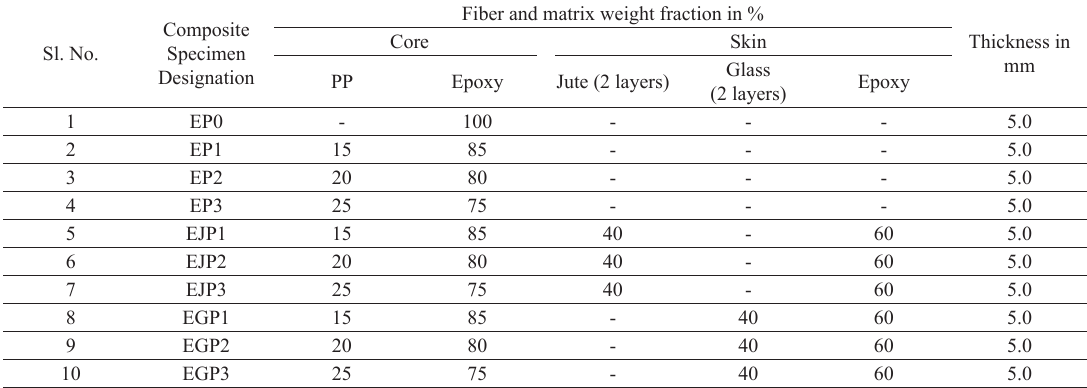
Table 1. Specimen designation with the composition.